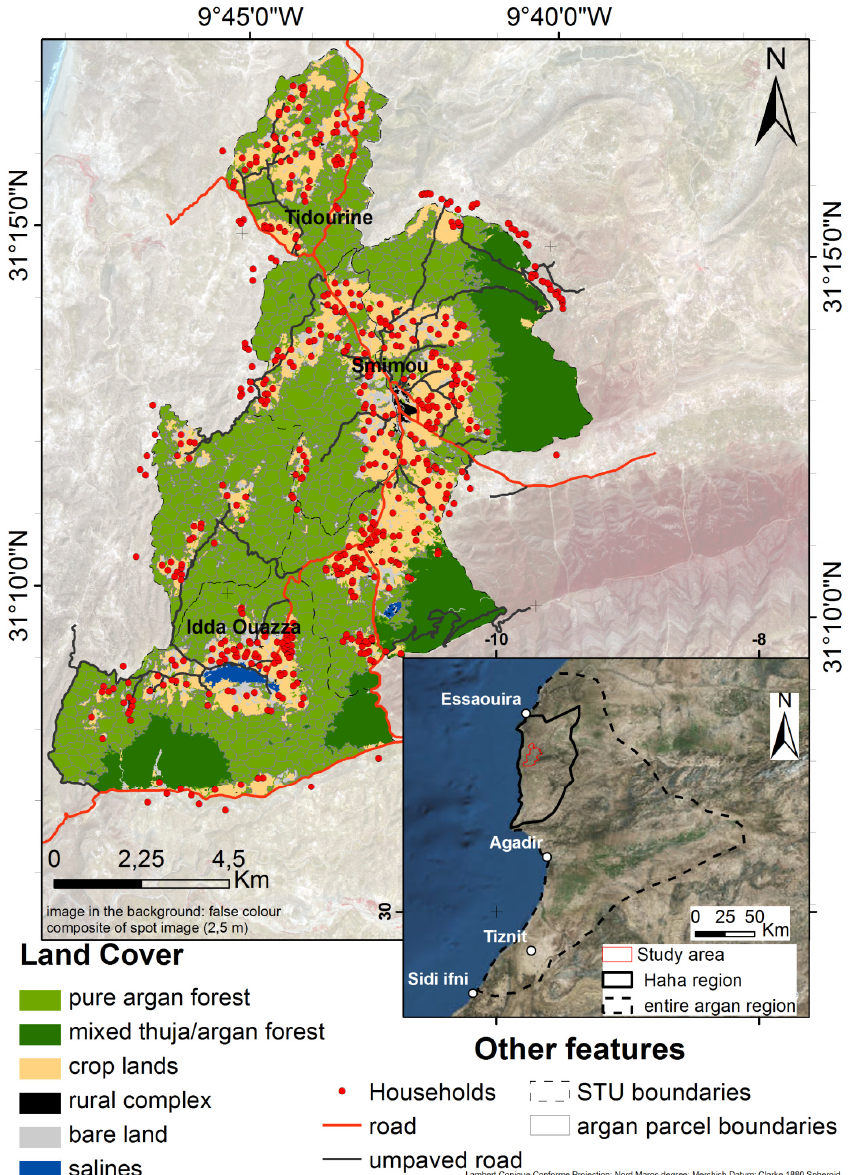
Figure 1. Study area showing land cover, socio-territorial units (STU) and argan parcels